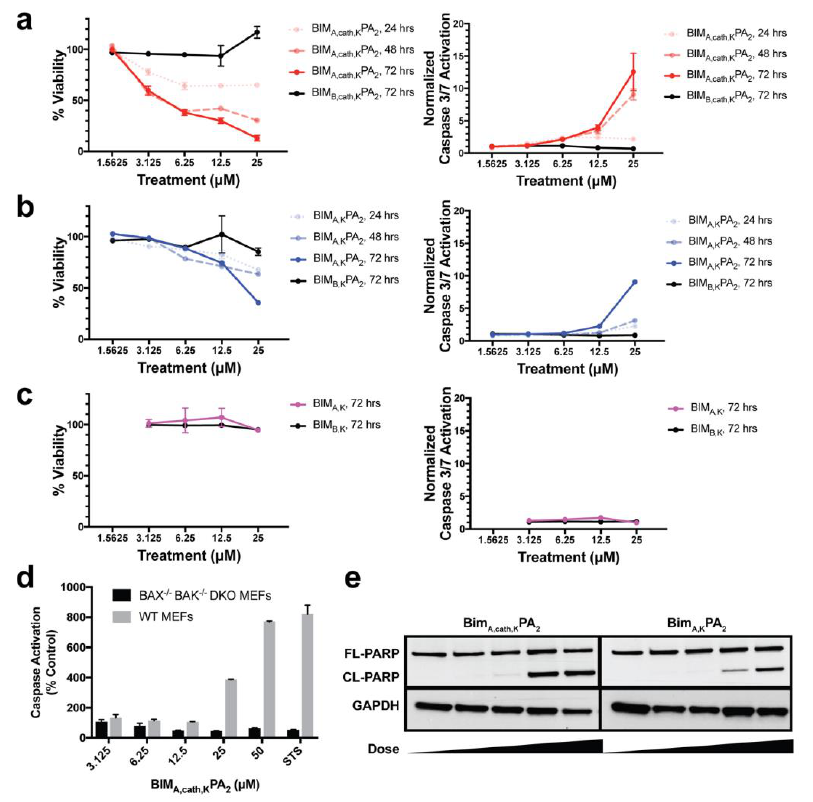
Figure 6. BIM A PAs induce dose- and time-dependent apoptotic cell death. WT MEFs were treated with ( a ) BIM A,cath,K PA 2 , ( b ) BIM A,K PA 2 , or ( c ) BIM A,K for 24, 48 and 72 h with serial dilutions of peptide or PA followed by measurement of cell viability (left column) and caspase-3 / 7 activation (right column). The corresponding, inactive BIM B peptides were used as negative controls. The cathepsin-cleavable BIM A,cath,K PA 2 induced potent cell death and corresponding caspase-3 / 7 activation within 24 h. The non-cleavable BIM A,K PA 2 induced a lesser degree of cell death with corresponding caspase-3 / 7 activation by 72 h. The BIM A,K peptide alone induced no measurable cell death or caspase-3 / 7 activation. ( d ) BIM A,cath,K PA 2 induction of caspase-3 / 7 activation was absent in BAX - / - BAK - / - MEFs indicating on-target specificity of the BIM A peptide. Staurosporine (STS; 1 µ M) was used as a positive control for caspase activation. ( e ) BIM A PAs induced dose-dependent PARP cleavage, another hallmark of apoptosis, as measured by Western blot analysis. FL = full length, CL = cleaved.